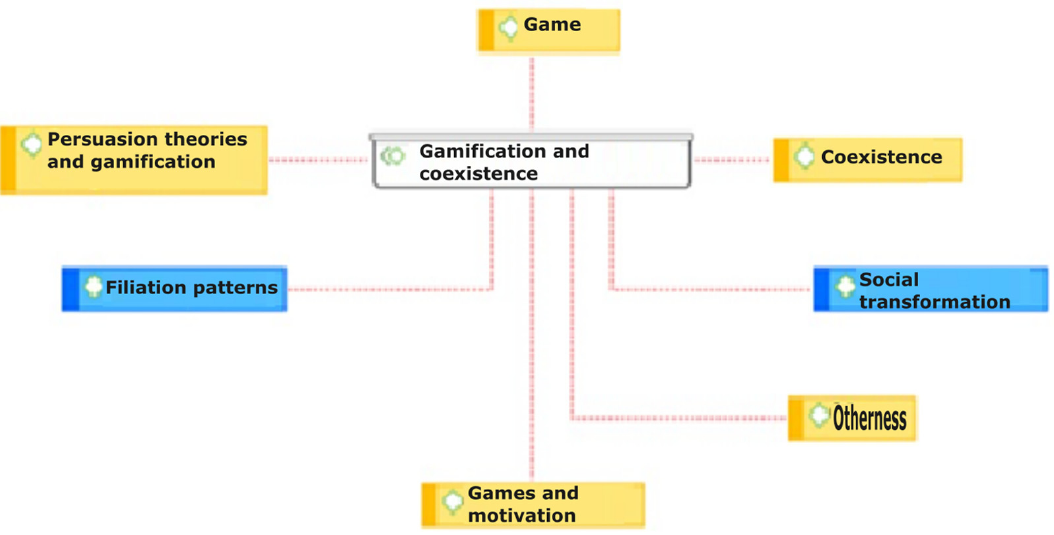
Figure 9. Edutainment network and coexistence. Source: Self-generated with the use of ATLAS.ti Software.